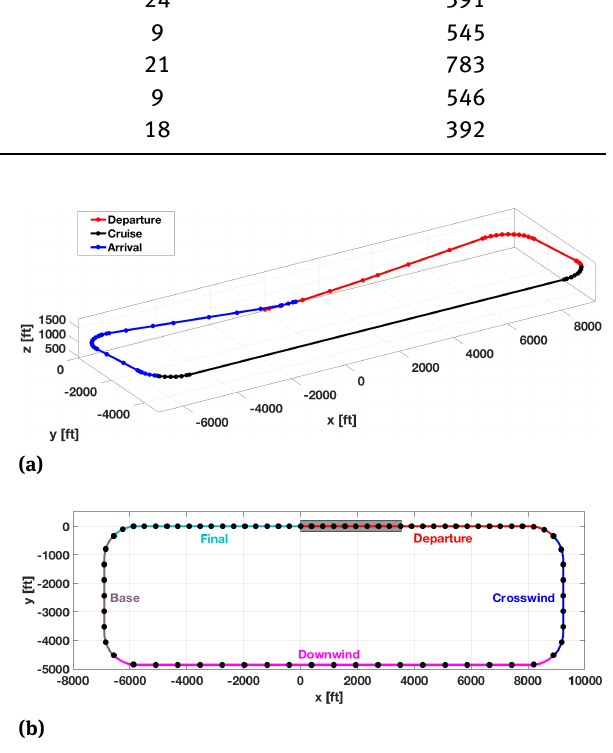
Figure 5: Geometry discretization (a) and noise sensor placement (b) of the RWY18 right-hand circuit of